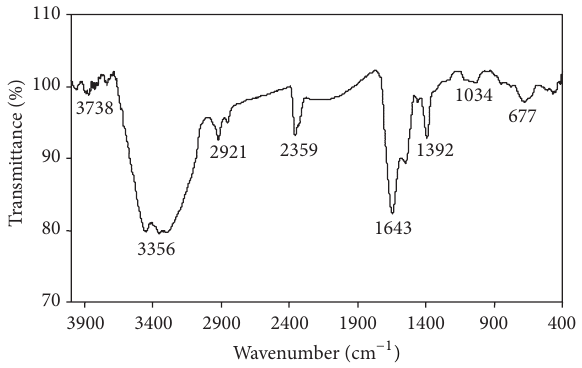
Figure 7: FTIR spectra of silver nanoparticle synthesized by Planomicrobium sp.